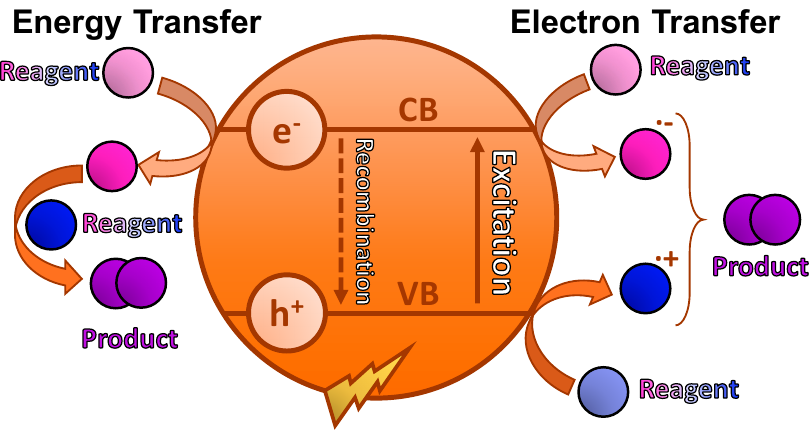
Figure 3. Energy transfer and electron transfer processes in photocatalysis.